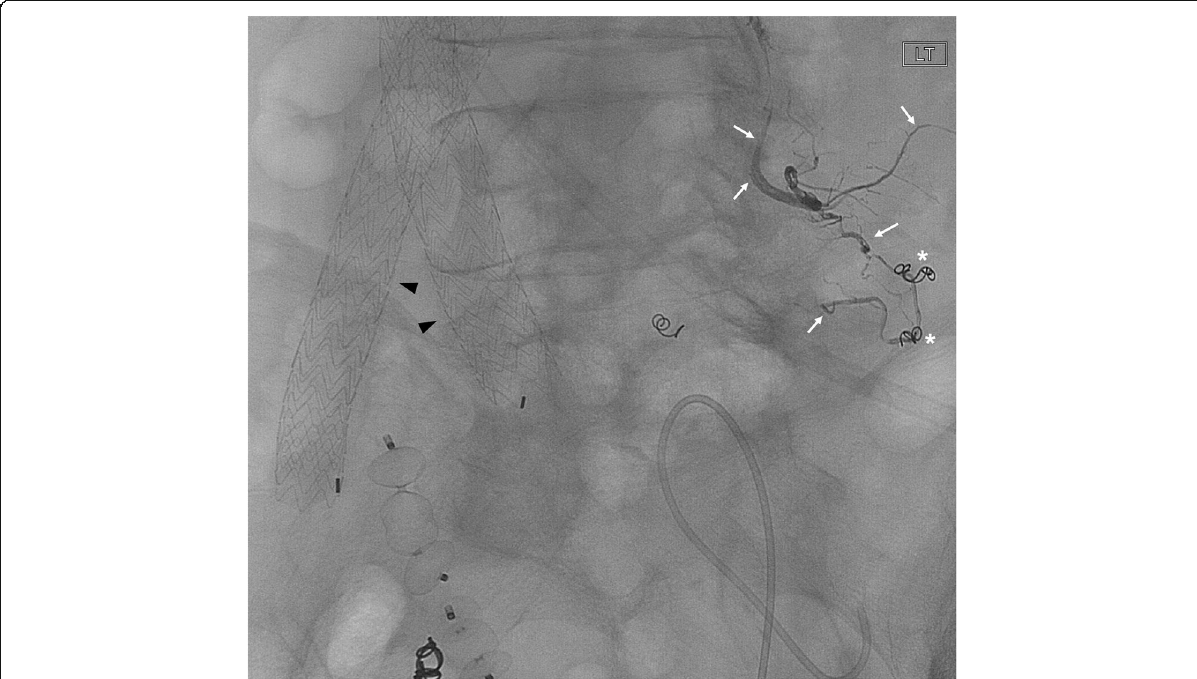
Fig. 1 75 year-old male with an enlarging AAA sac status post endovascular repair (arrowhead). Fluoroscopic image demonstrates EVOH (Onyx 34) embolization of a third order branch of L4 Lumbar artery (arrows) which was leading to type II endoleak. Prior attempt of coil embolization of this endoleak was unsuccessful (asterisk)